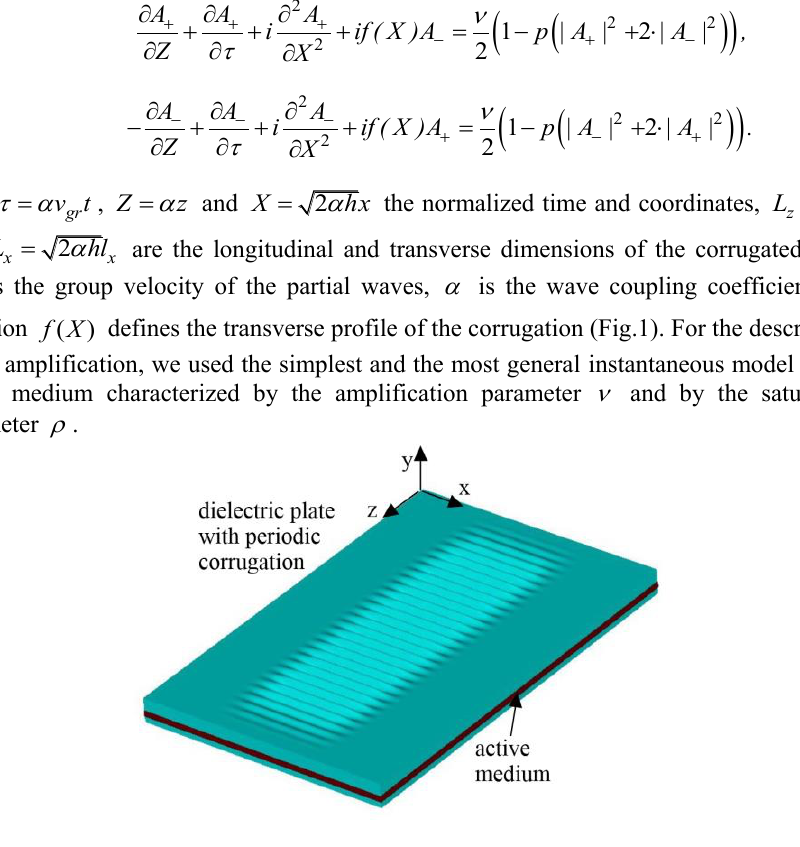
Fig. 1. Scheme of DFB